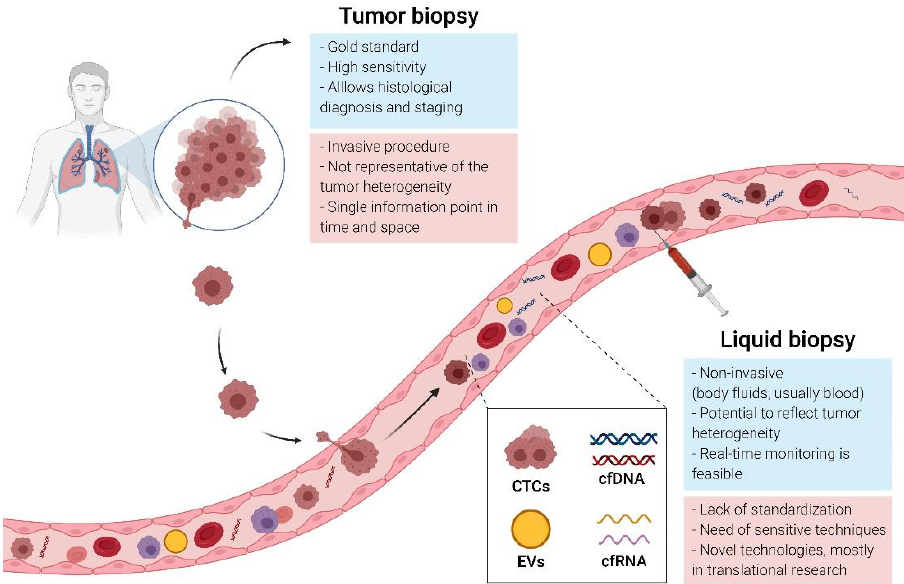
Figure 1. Tissue versus liquid biopsy: comparison of the advantages and limitations.